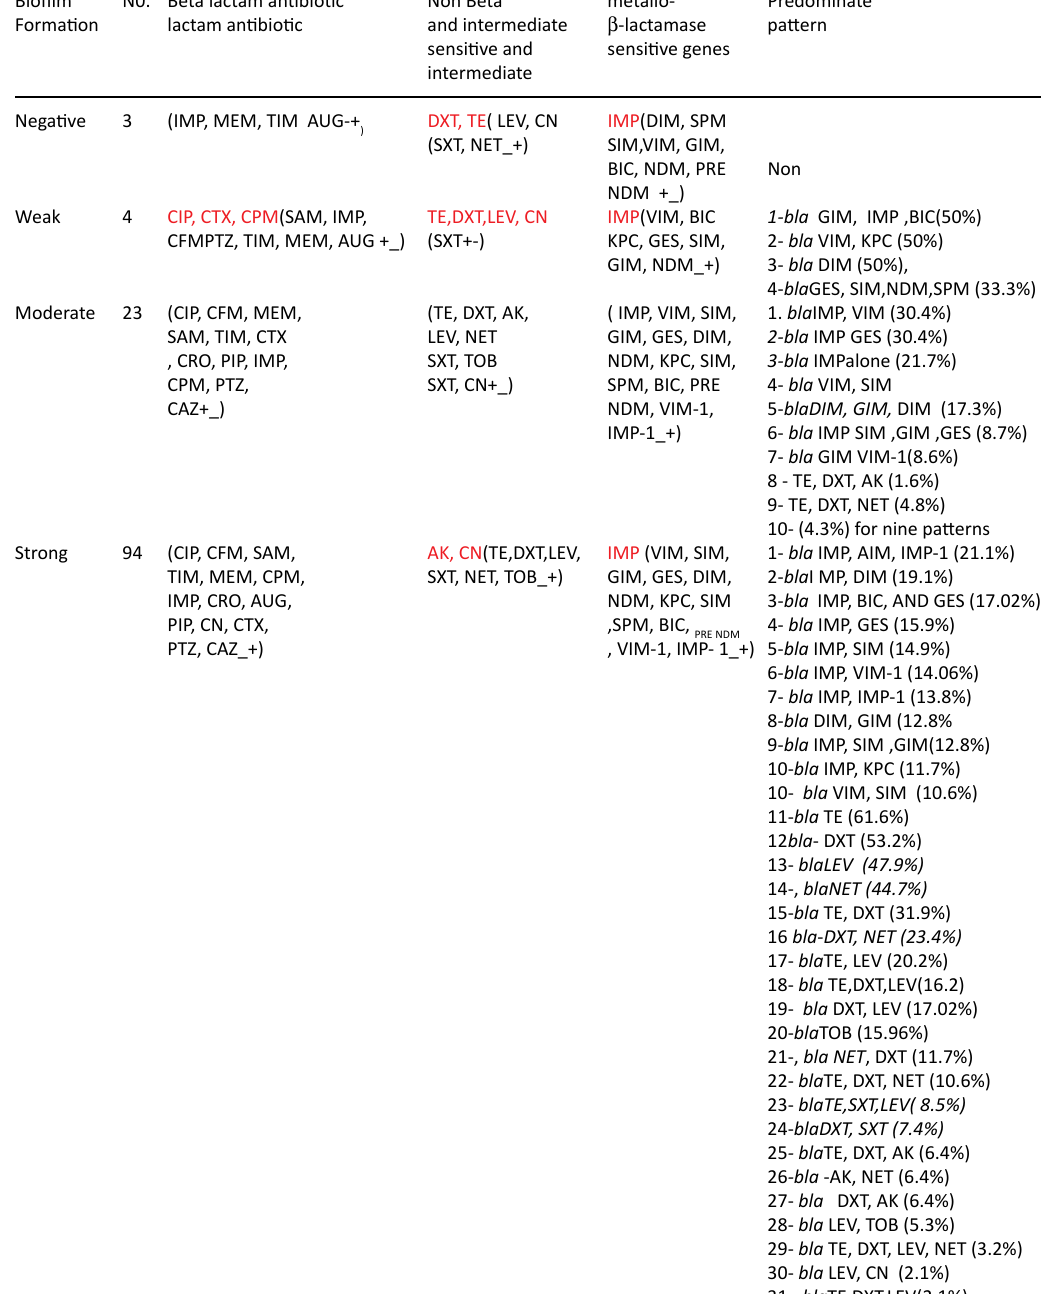
Table 2. Grouping of A. baumannii according to antibiotic sensitivity, antibiotic genes patteren and bioflim formation Biofilm